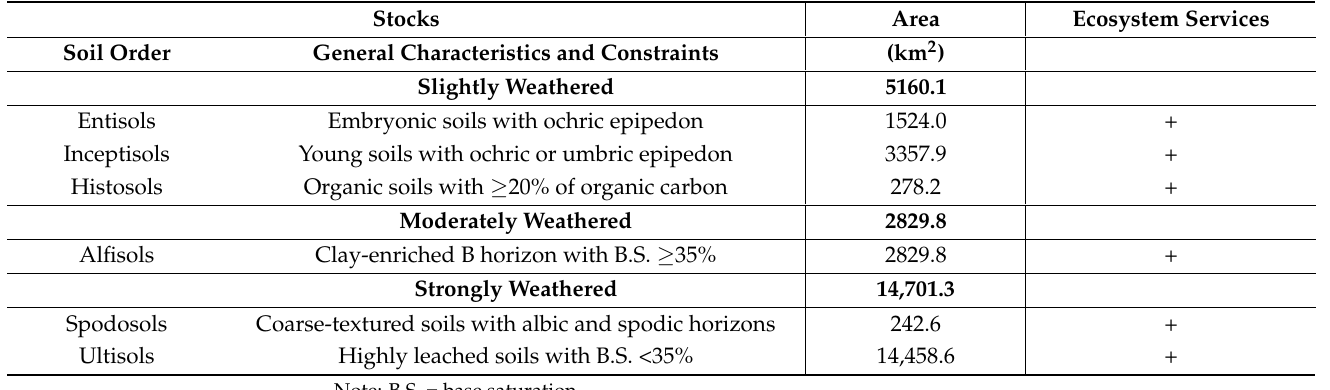
Table 1. Soil taxonomic variety and ecosystem services (provisioning, regulation/maintenance, cul-